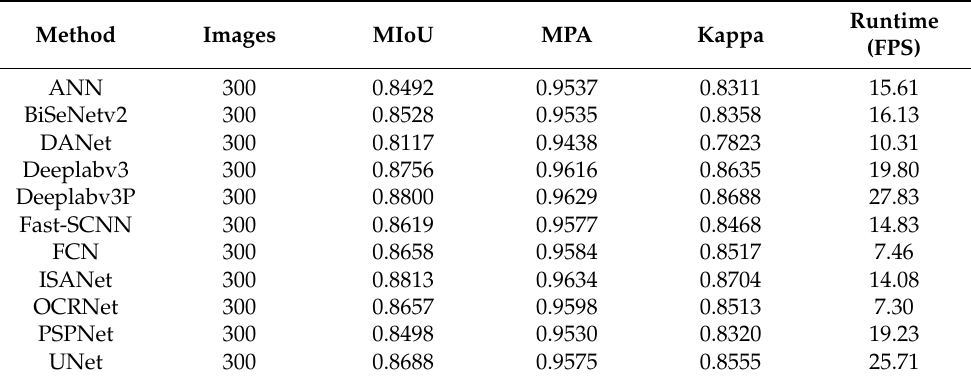
Figure 16. S egmentation result of 11 models on the right eye data. Figure 16. Segmentation result of 11 models on the right eye data. Table 3. Comparison of performance indicators of the 11 models on the right eye